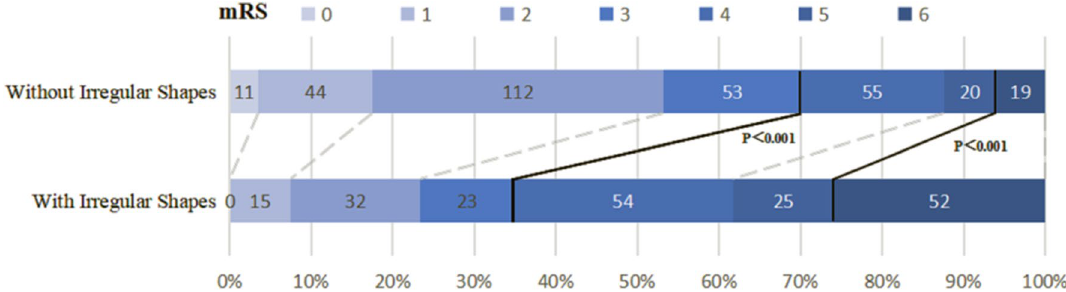
Figure 2. Distribution of the modified Rankin Scale (mRS) scores according to the presence or absence of irregular shapes. The bold line separates favorable (mRS, 0–3) and poor outcomes (mRS, 4–6) or survival and